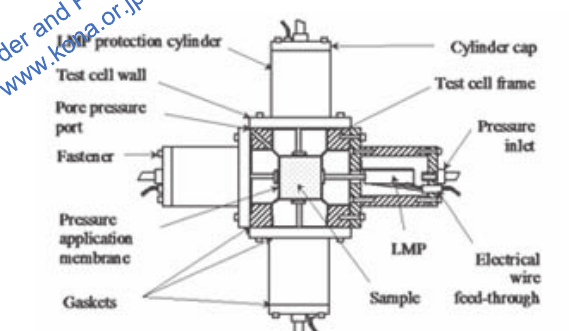
Fig. 1 Cross-sectional view of CTT (Kamath and Puri, 1997) (not to